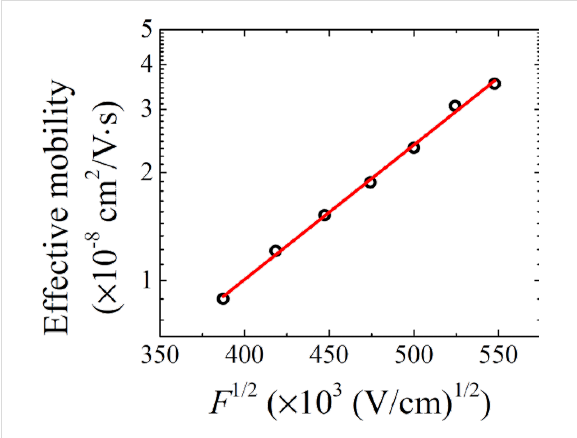
Figure 4: Electric field dependence of the effective mobility at the tem- perature of 300 K. The solid line represents the linear fit.